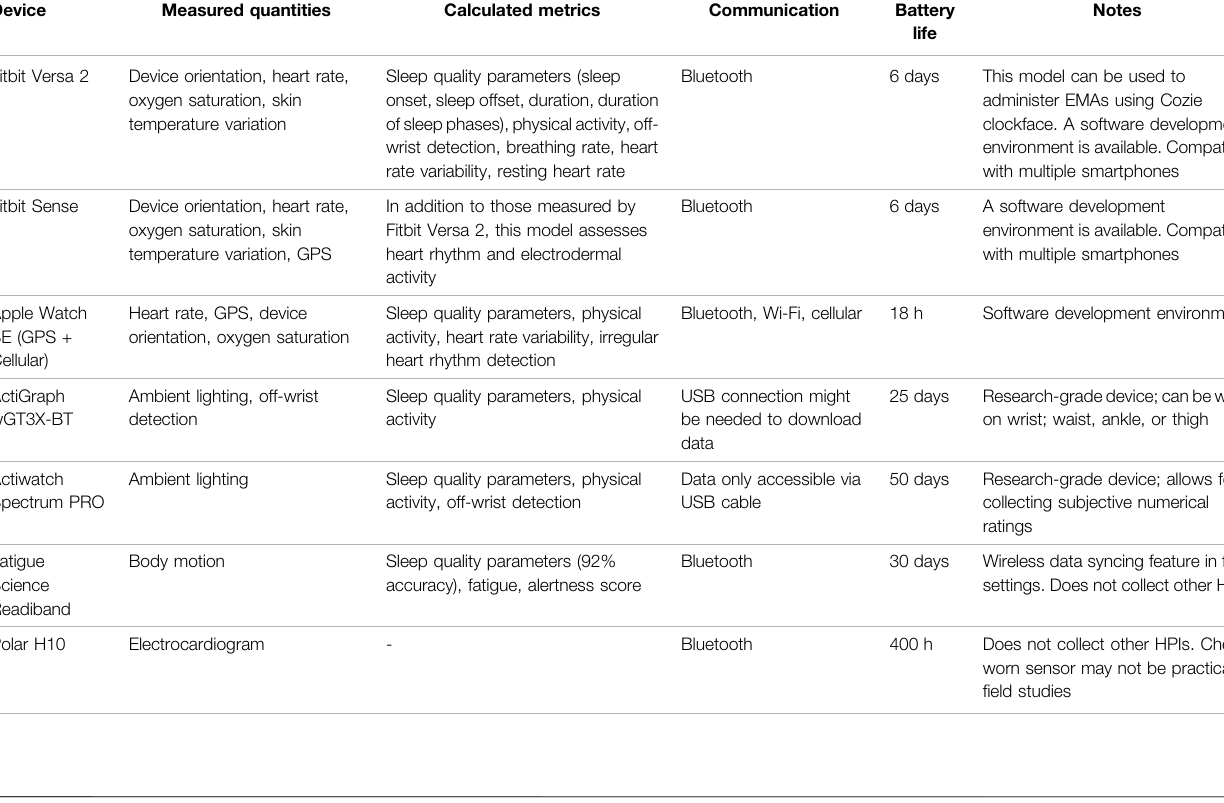
TABLE 2 | A summary of wearable devices that were considered for the data-accessibility investigation.